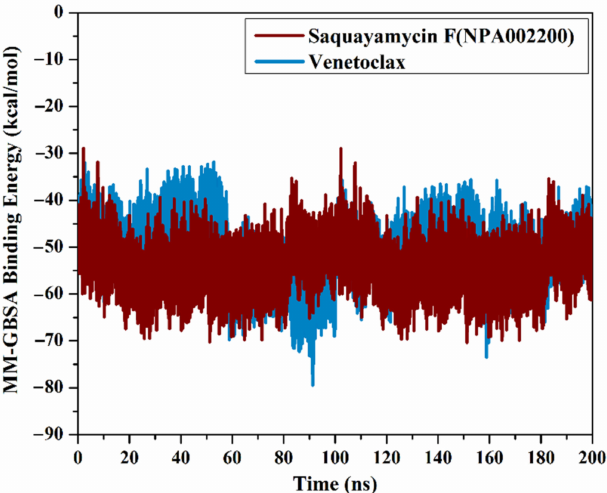
Figure 6. The evaluated MM-GBSA binding energies of saquayamycin F (NPA002200) (in dark red) and venetoclax (light blue) with the Bcl-2 protein throughout the 200 ns MD course.